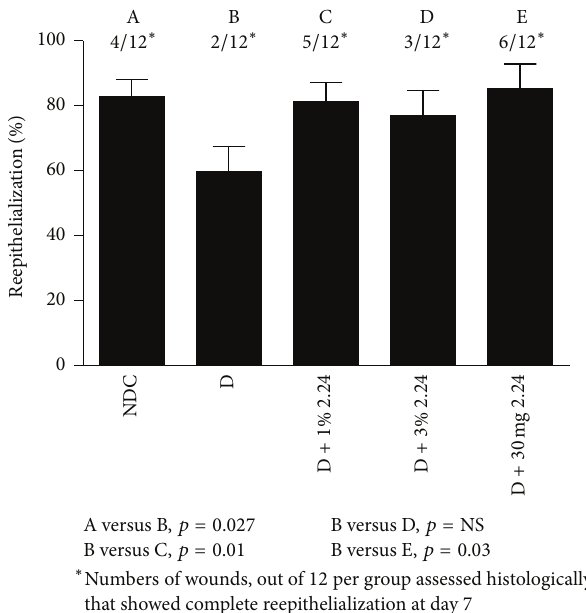
Figure 6: Histomorphometric analysis of reepithelialization of standardized skin wounds in nondiabetic control (NDC) and diabetic rats treated with vehicle (D) or with a 1% or 3% CMC2.24 topically applied (D + 1% 2.24 or D + 3% 2.24, resp.) or with 30 mg/kg CMC2.24 administered systemically by oral intubation (D + 30 mg 2.24). Each value (%) represents the mean closure of the epithelium, assessed histologically, for 12 histological slices per group ± SEM, and the letters, A–E, assign statistically significant differences between the experimental groups. The star ( ∗ ) symbol represents the numbers of wounds per group showing complete reepithelization on day 7.